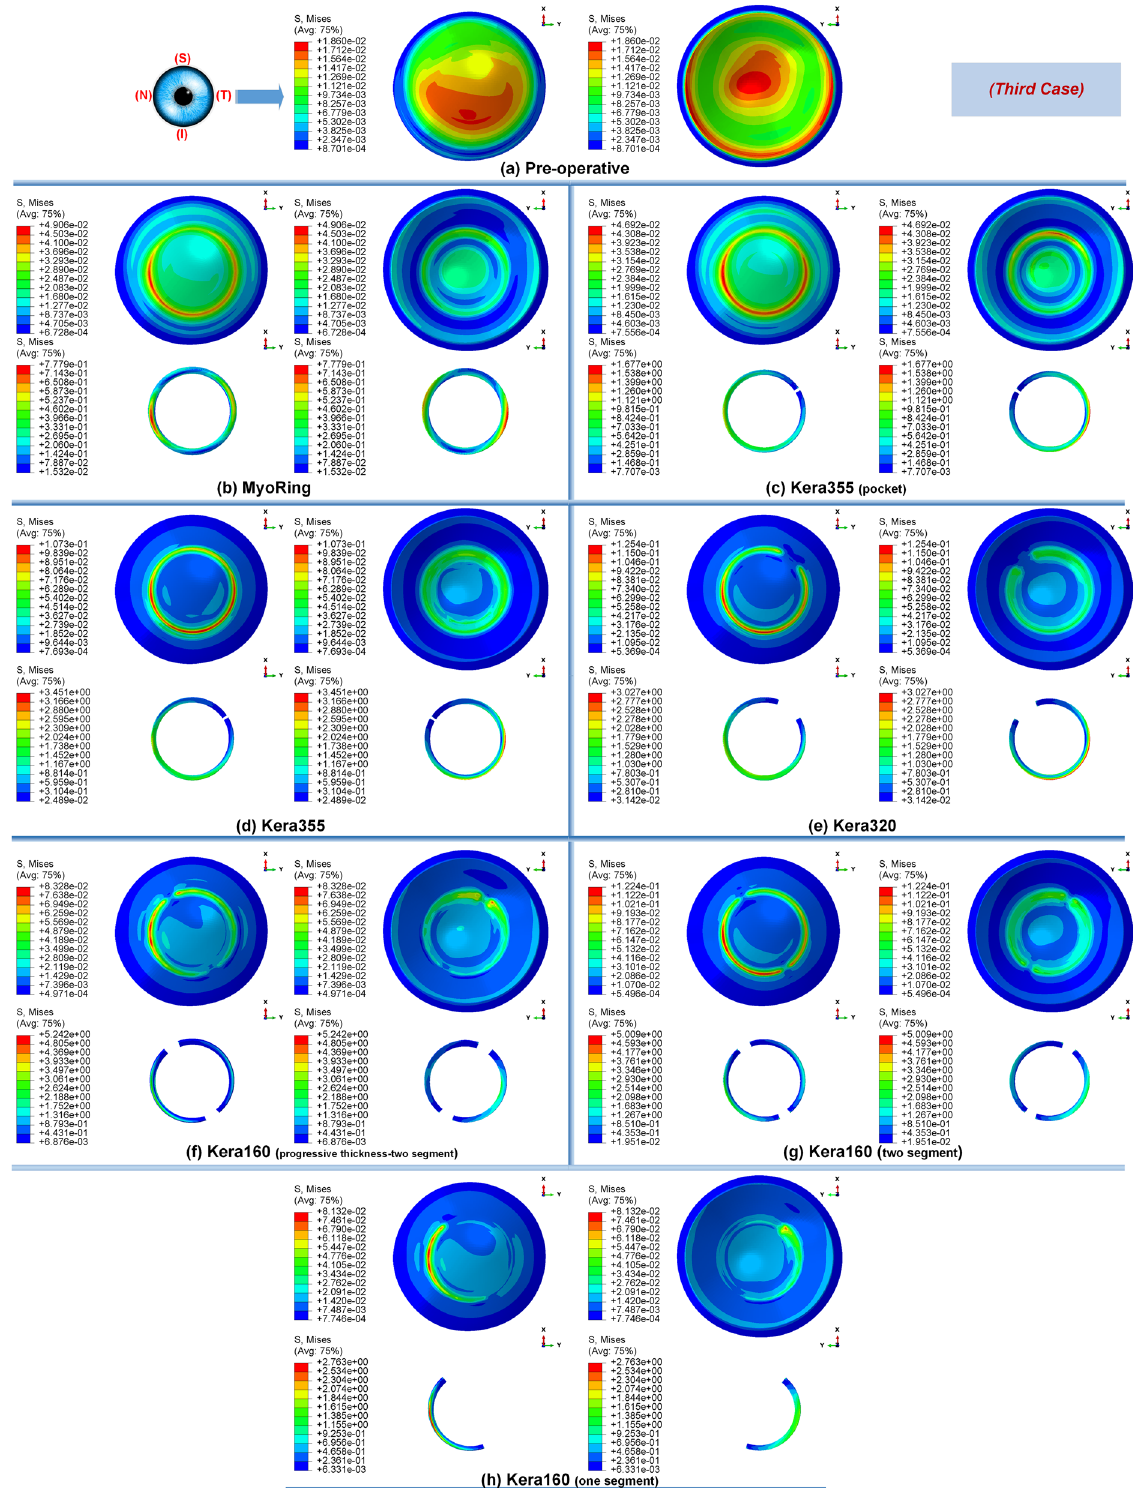
Figure 14. The pre- and post-operative contour diagrams of the Von Mises stress distribution (MPa) in FEM of different surgical scenarios (third case): ( a ) preoperative; ( b ) MyoRing; ( c ) Kera355 implemented by pocket incision; ( d ) Kera355; ( e ) Kera320; ( f ) Kera160-two prog segments; ( g ) Kera160-two segments; ( h ) Kera160-one prog